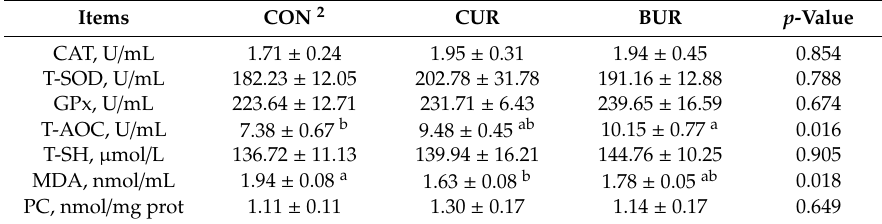
Table 4. E ff ect of curcumin and bisdemethoxycurcumin on serum antioxidant capacity in broilers (Experiment 2) 1 .